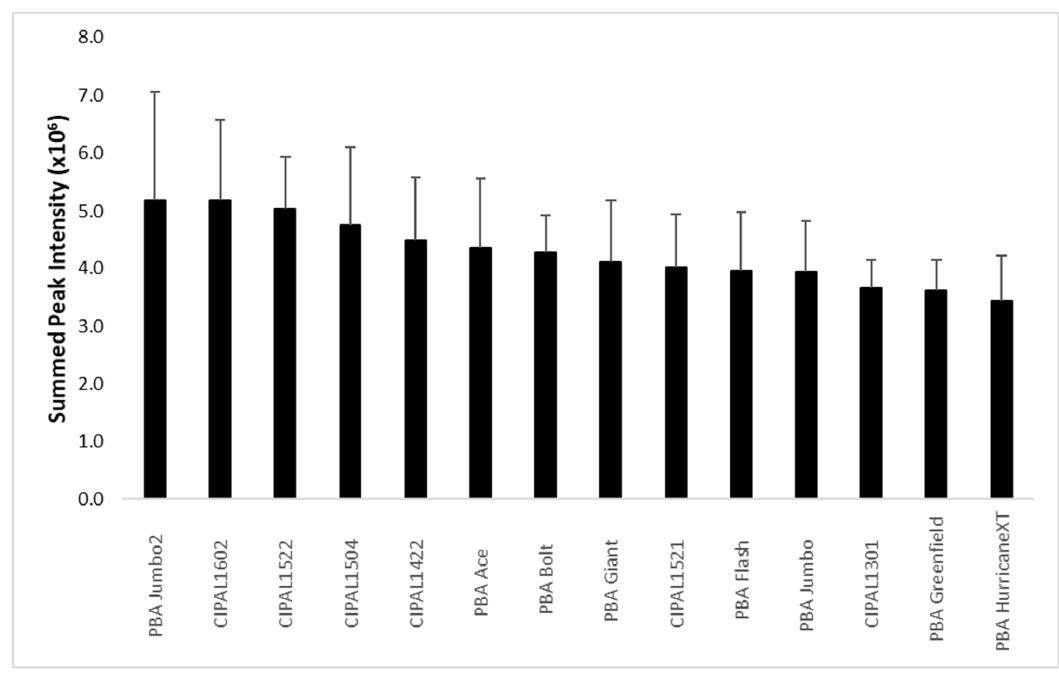
Figure 8. Relative content and standard deviation across reps and sites of kaempferol derivatives in the lentil hulls.